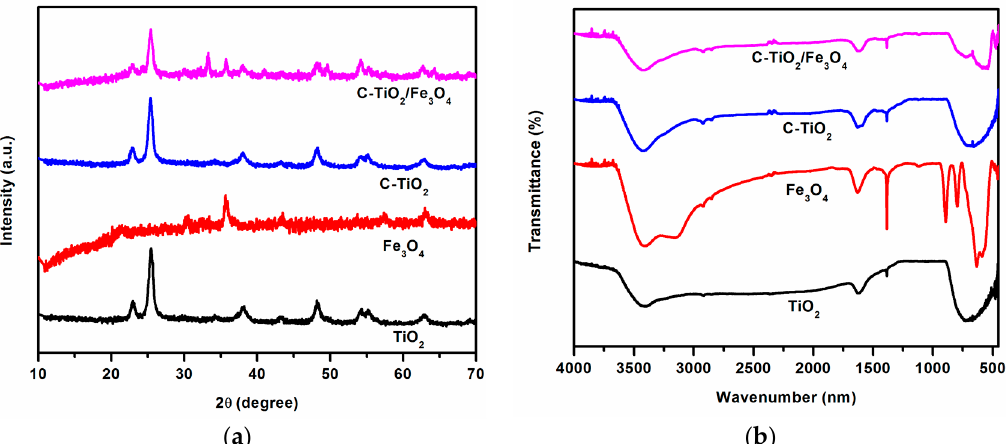
Figure 1. ( a ) XRD pattern of TiO 2 , Fe 3 O 4 , C-TiO 2 , and C-TiO 2 / Fe 3 O 4 nanocomposites and ( b ) FTIR spectra of TiO 2 , Fe 3 O 4 , C-TiO 2 , and C-TiO 2 / Fe 3 O 4 composites. The morphologies of TiO 2 , Fe 3 O 4 , C-TiO 2 , and C-TiO 2 /Fe 3 O 4 samples were examined using SEM